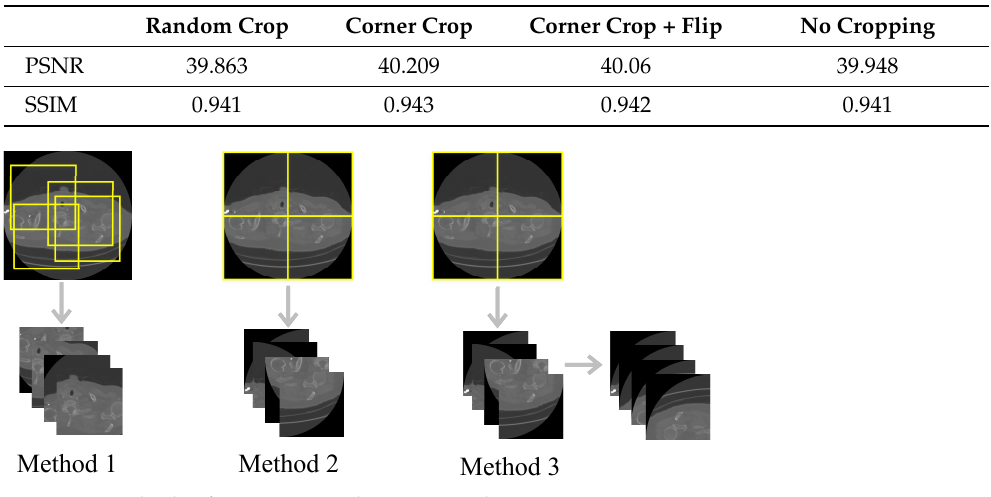
Figure 9. Methods of cropping patches in stage three.